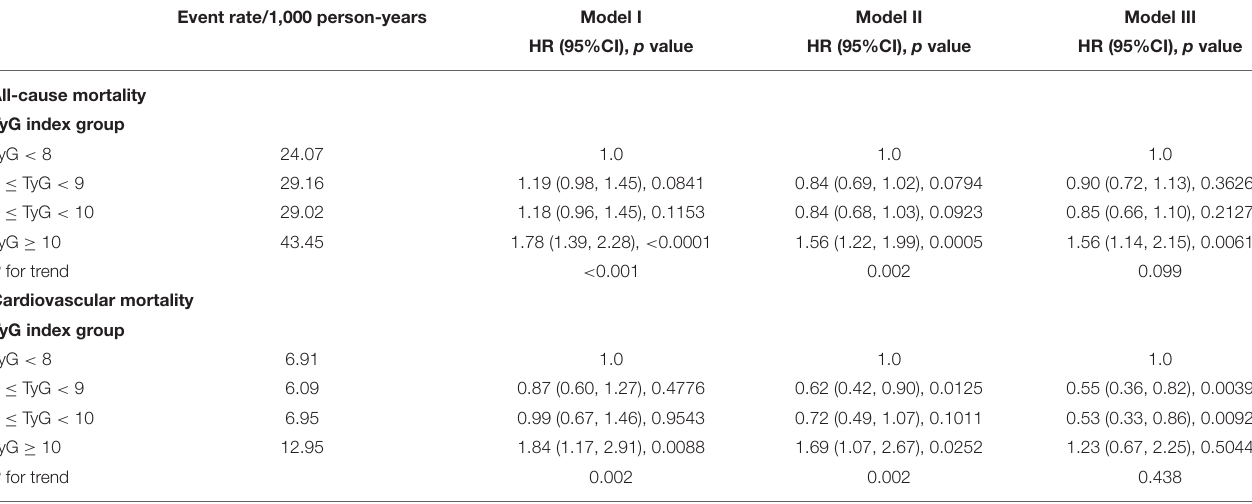
TABLE 2 | Multivariate Cox regression analysis of triglyceride-glucose index with cause-specific